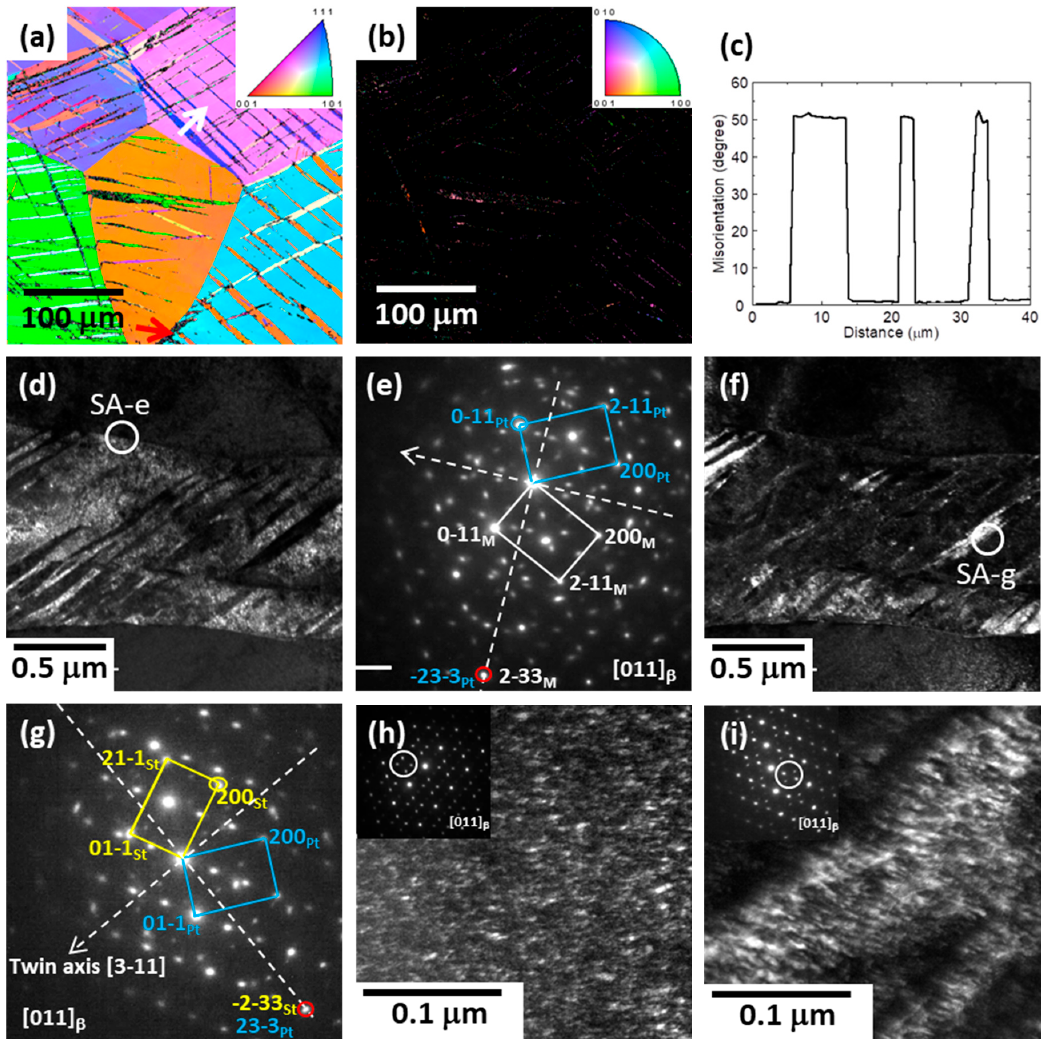
Figure 4. EBSD and TEM analysis of the specimen compressed at a hydrostatic pressure of 5 GPa: ( a ) EBSD inverse pole figure map of β phase, ( b ) EBSD inverse pole figure map of SIM α″ phase, ( c ) line traces across the region indicated by white arrows in ( a ) showing the misorientation angle, ( d ) dark field image of primary {332}<113> twin, ( e ) the corresponding SAED pattern illustrates twinning plane and twinning axis of primary {332}<113> twin, ( f ) dark field image of secondary {332}<113> twins, ( g ) the corresponding SAED pattern illustrates twinning plane and twinning axis of secondary {332}<113> twins, ( h ) dark field image of ω phase in the matrix and the corresponding SAED pattern and ( i ) dark field image of ω phase in the primary {332}<113> twin and the corresponding SAED pattern. The subscripts “M”, “Pt” and “St” denote β matrix, primary twin and secondary twin, respectively. For Ti-10Mo alloy, the average values of Bo and Md are calculated to be 2.805 and 2.421 based on the equation proposed in [15]. It locates at the region where SIM α″ phase transformation is the dominant deformation mechanism in the Bo (cid:3364)(cid:3364)(cid:3364)(cid:3364) -Md (cid:3364)(cid:3364)(cid:3364)(cid:3364)(cid:3364) diagram. Min et al. [8] reported that the tensile deformation modes of Ti-10Mo alloy underwent a transition from SIM α″ phase transformation to